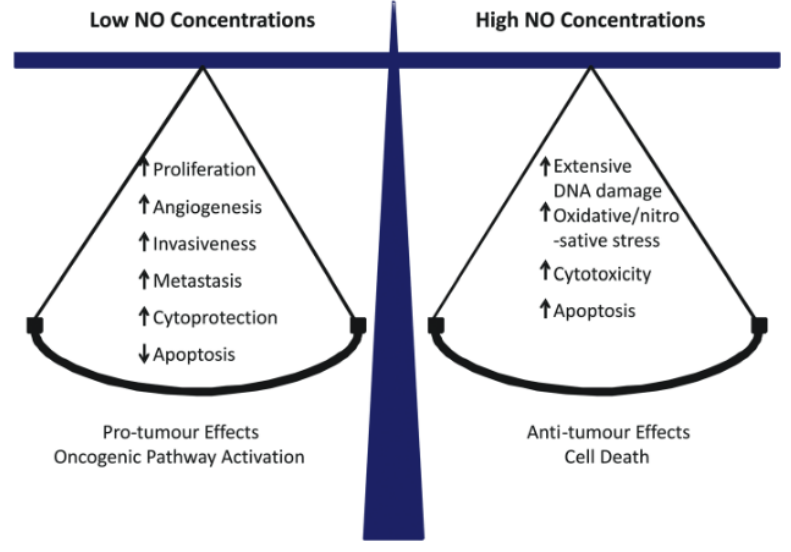
Figure 1. Concentration-dependent effects of NO in cancer: pro-tumor versus anti-tumor. Reproduced from Reference [24], with permission.